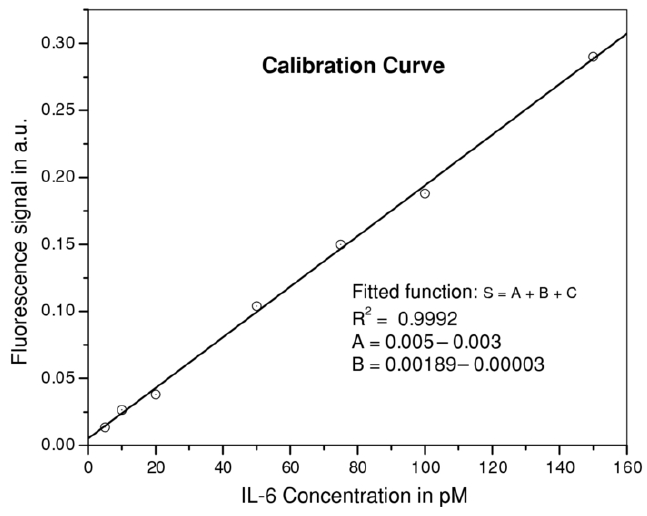
Figure 10. Calibration curve of the IL-6 sensor in the pM range. Reprinted with permission from [70].